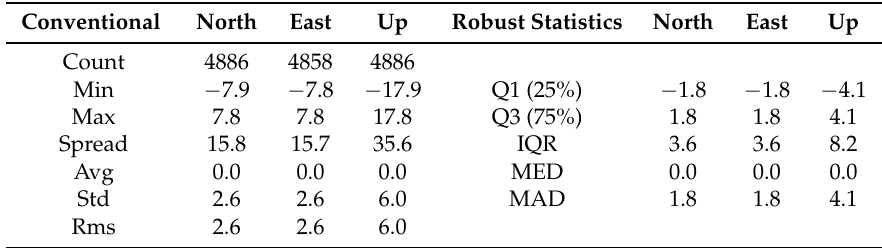
Table 4. Conventional and robust statistics to assess the accuracy of RTKLIB solution with respect to GIPSY solution [unit: mm].